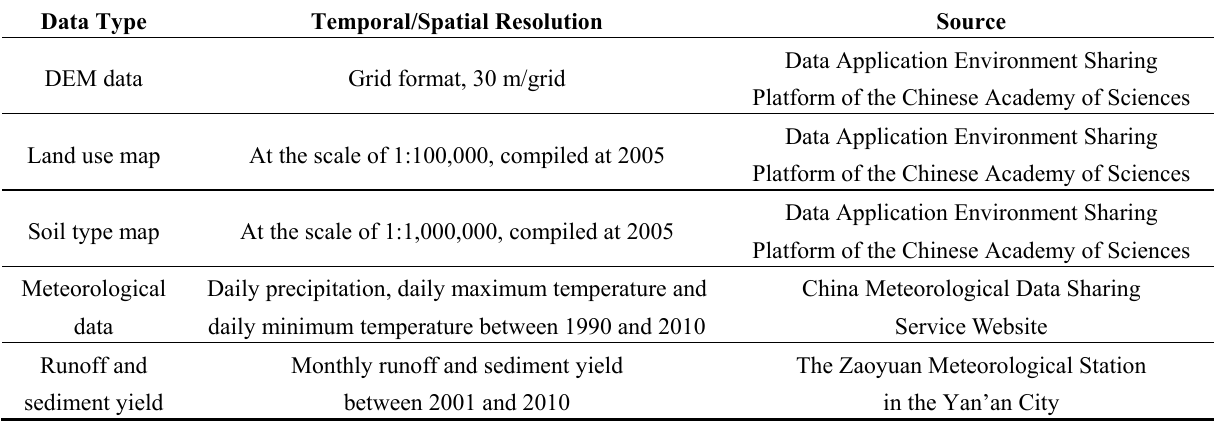
Table 1. List of data that were used in this